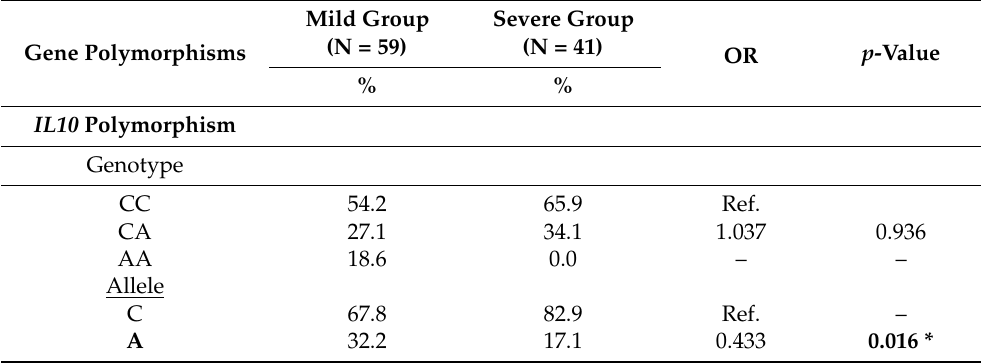
Table 2. Odds ratio (OR) for IL-10 , MTP , SOD2 , and APOE (genotypes and alleles) for both